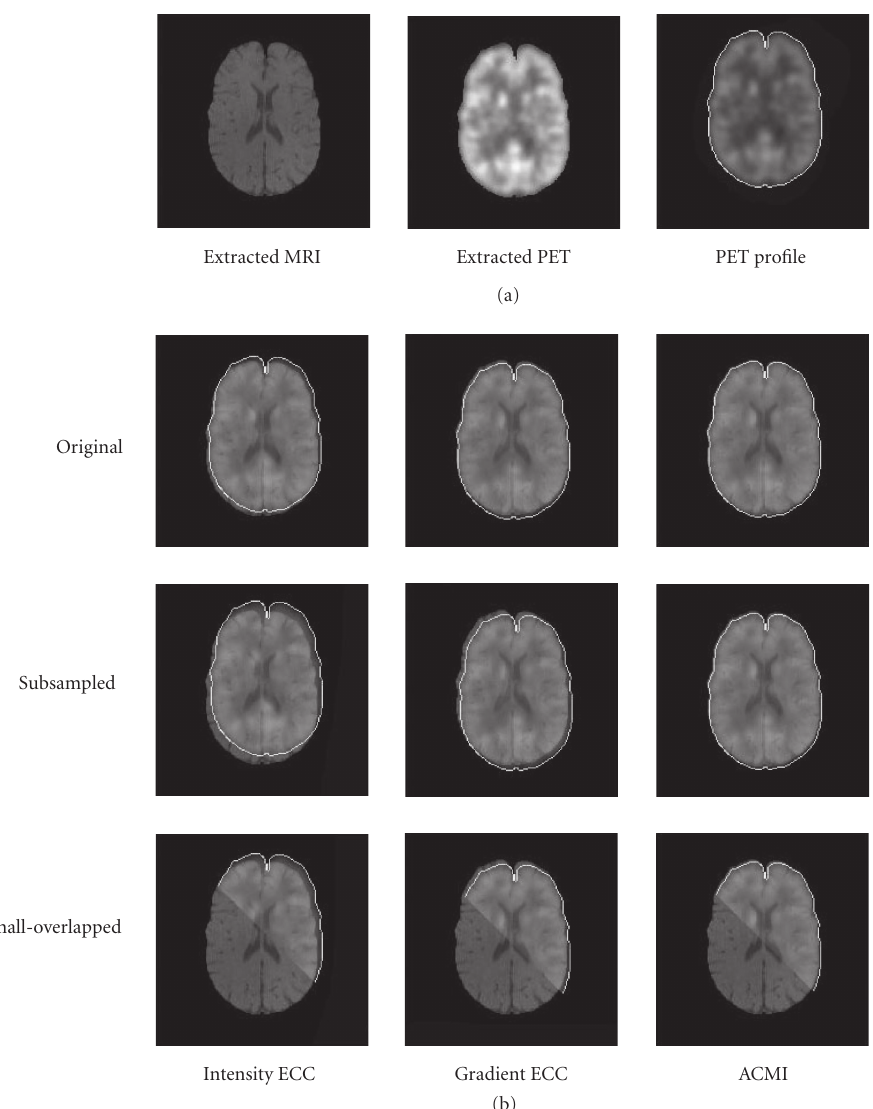
Figure 7: Illustration of registration results of PET/MRI T1 pair with intensity ECC, gradient ECC, and ACMI. (a) The extracted brain of MRI T1 image (left) and the 50% transparent profile of extracted brain of PET image (right) are served as the underlying and the overlying, respectively. (b) The first row: registration results of original version using intensity ECC, gradient ECC, and ACMI; the second row: the corresponding results of subsampled version; the third row: the corresponding results of small-overlapped